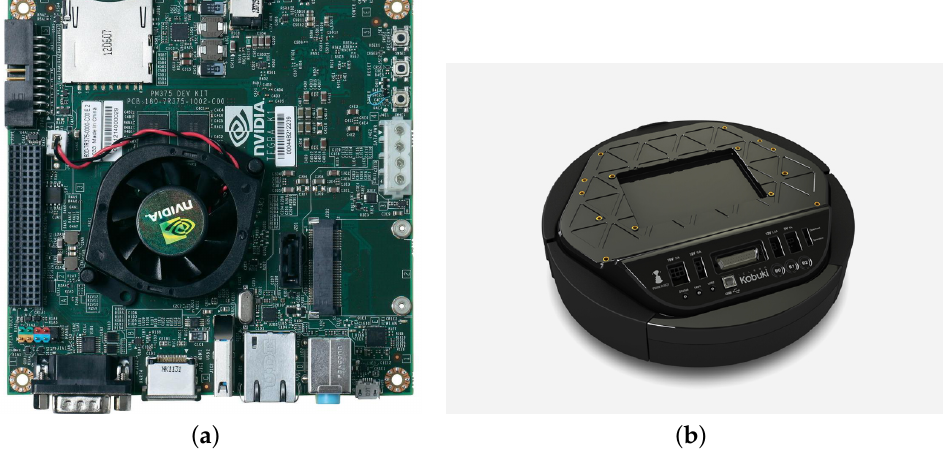
Figure 13. TK1 and Kobuki Yujin. ( a ) Nvidia TK1 board, the Central Processing Part of the Robot; ( b ) Kobuki Yujin, it is the moving platform of the robot and also the energy source for all the